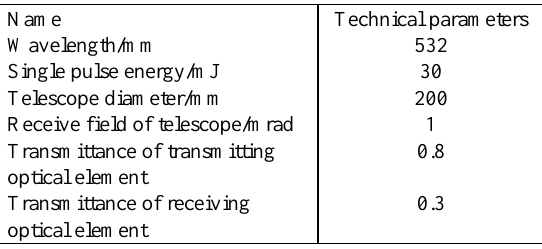
Table 1. The parameters of ground-based lidar